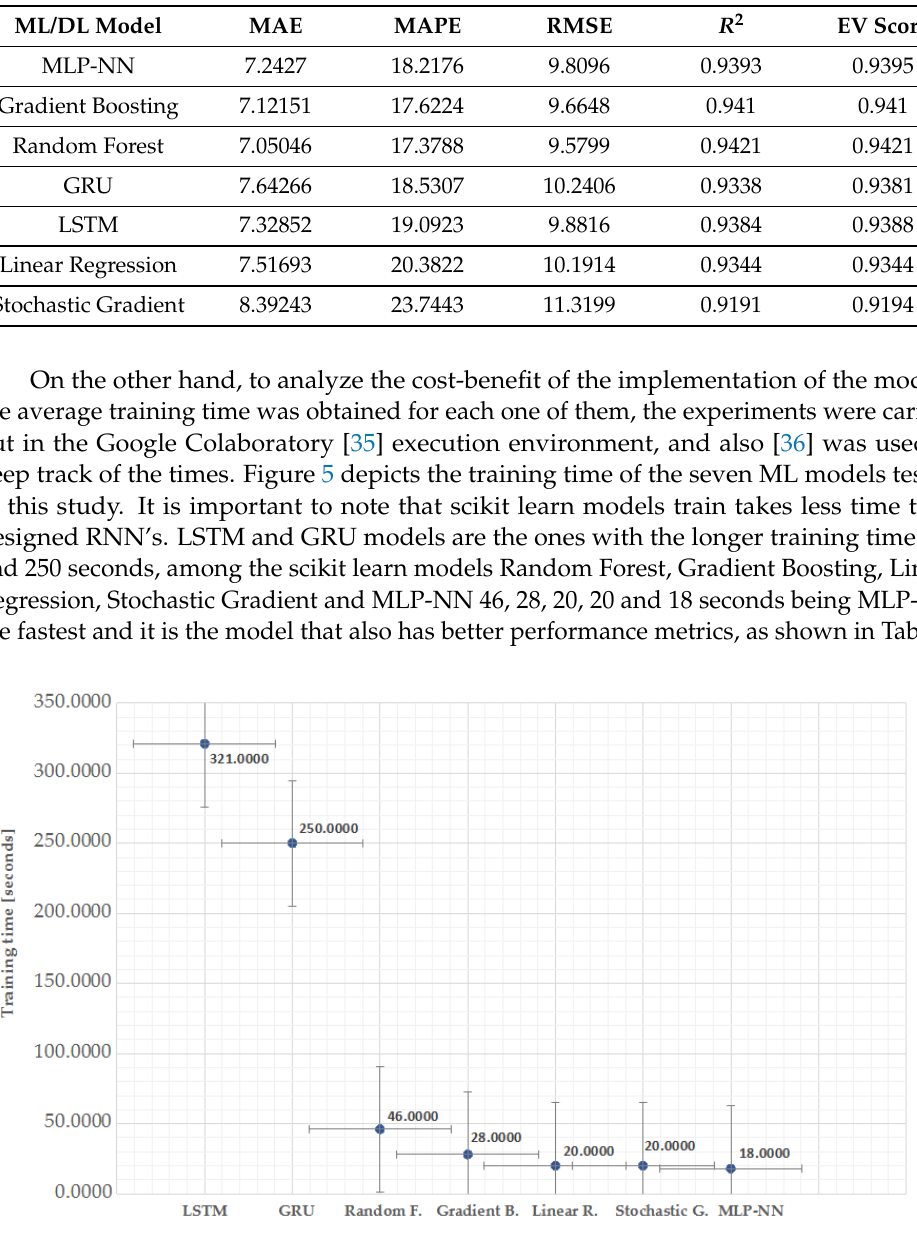
Figure 5. Comparison of training